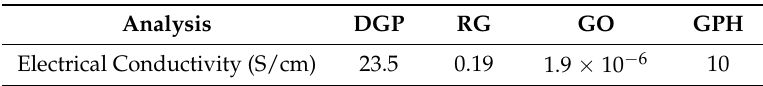
Table 2. Electrical conductivity values for graphite (GPH), graphene oxide (GO), reduced graphene oxide (RGO) and dispersed graphene nanoplatelets (DGP).